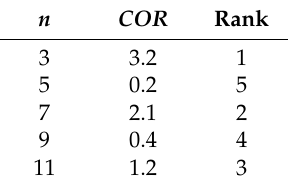
Table 6. COR rank by n value.